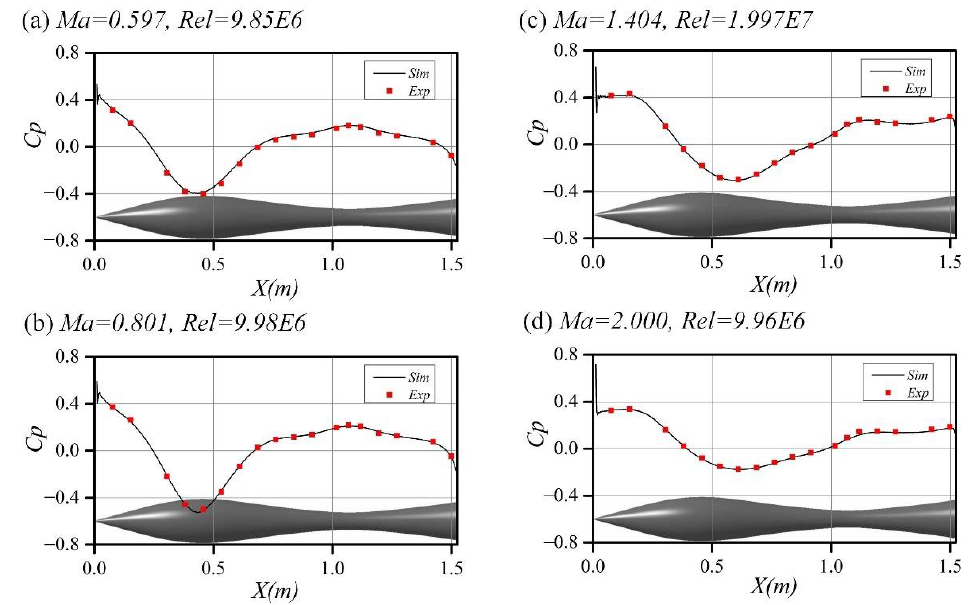
Figure 5. Comparison of the simulation and experimental C P along the longitudinal symmetry line over the upper surface of the waisted body: ( a ) Ma = 0.597, Re = 9.85 × 10 6 , ( b ) Ma = 0.801, Re = 9.98 × 10 6 , ( c ) Ma = 1.404, Re = 1.997 × 10 7 , ( d ) Ma = 2.000, Re = 9.96 × 10 6 .